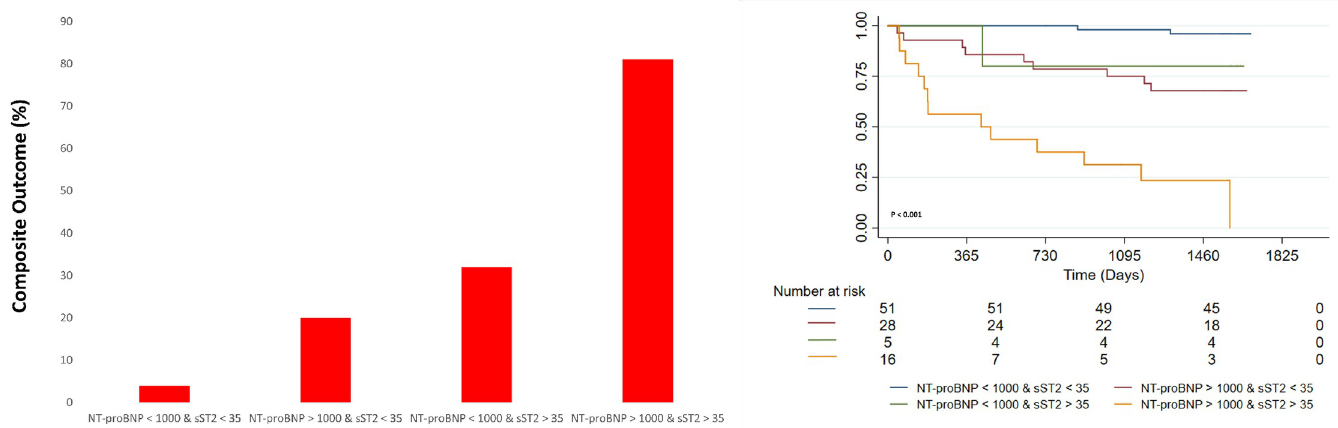
Fig 2. Bar graph and Kaplan Meier survival analyses for the composite outcome stratified by combined NT-proBNP and ST2 according to selected cut-off values.